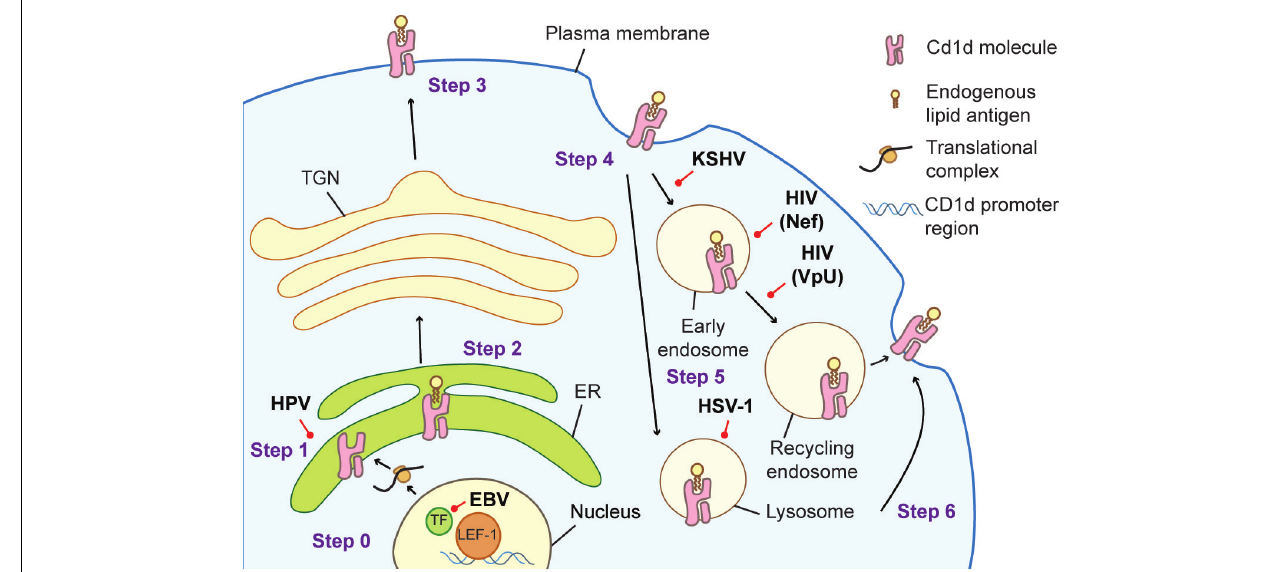
traffics to the plasma membrane. Step 4: CD1d is internalized into the endocytic compartments. The MIR protein of KSHV can promote endocytosis (25). The HIV protein Nef accelerates CD1d internalization (22, 60), while VpU retains it in early endosome (59). HSV-1 infection results in CD1d retention in the lysosomal limiting membrane (21), and two HSV-1 proteins gB and US3 direct CD1d to lysosomal degradation (55). Step 5: the exchange for the antigenic lipid occurs in the lysosome. Step 6: CD1d returns to the plasma membrane to present lipid antigen to iNKT cell membrane to present lipid antigen to iNKT